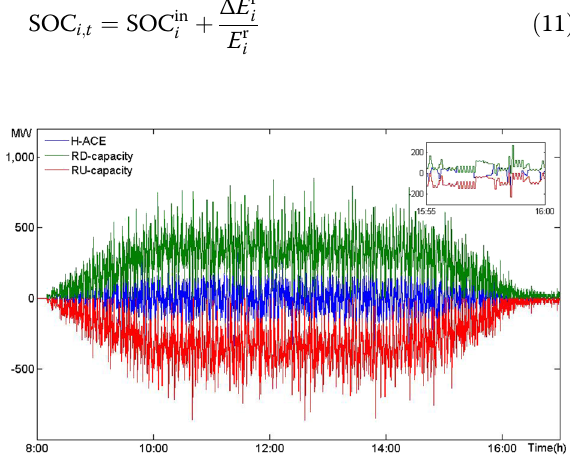
Fig. 10 The dispatch of H-ACE within the capacity of EVs for regulation